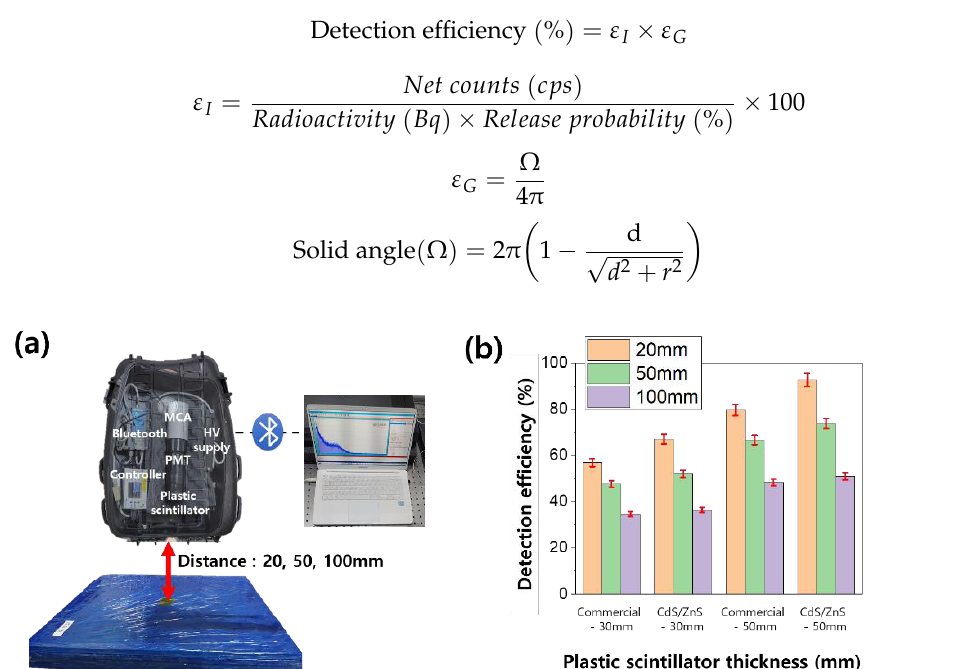
Figure 10. ( a ) Wireless radiation detection system of the CdS/ZnS plastic scintillator and commercial plastic scintillator by soil source position ( b ) and detection efficiency . Table 2. The total count (cps) by plastic type and distance from the source.